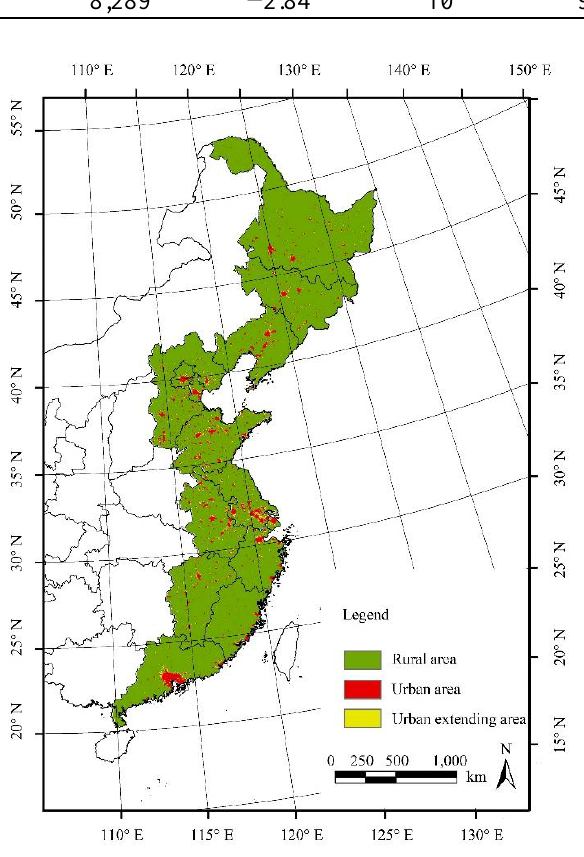
Figure 2. Distribution of urban expansion in Eastern China from 1999 to